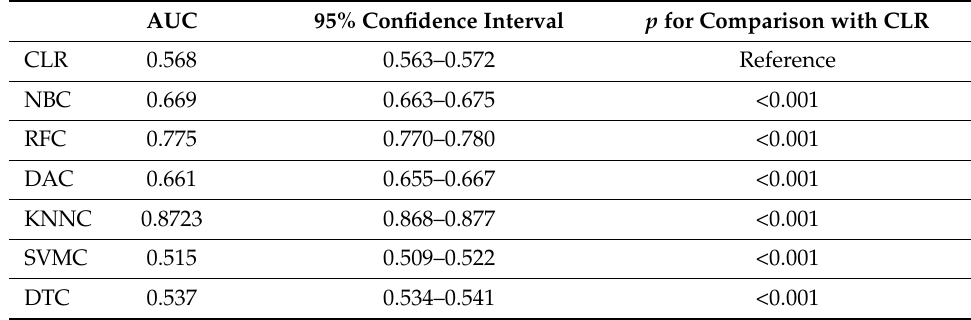
Table 5. Performance comparison with conventional logistic regression model for total set (maximum sensitivity